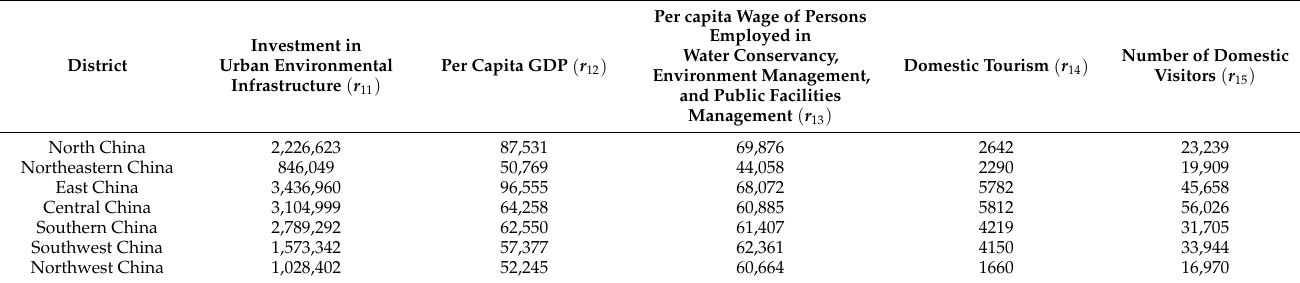
Table 3. Mean value of green infrastructure economic function evaluation index in different regions.